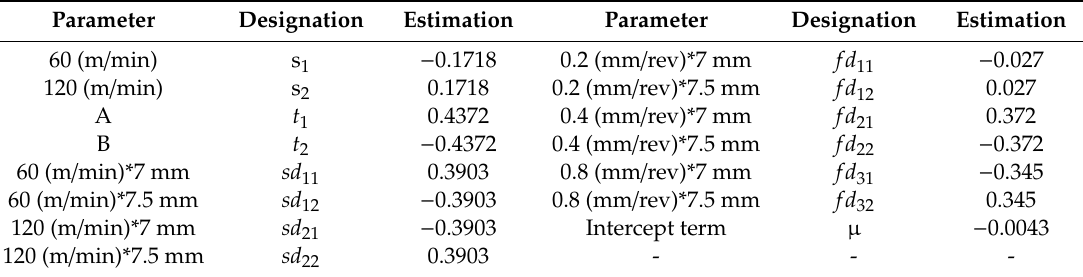
Table 6. Estimation parameters of the predictive model.